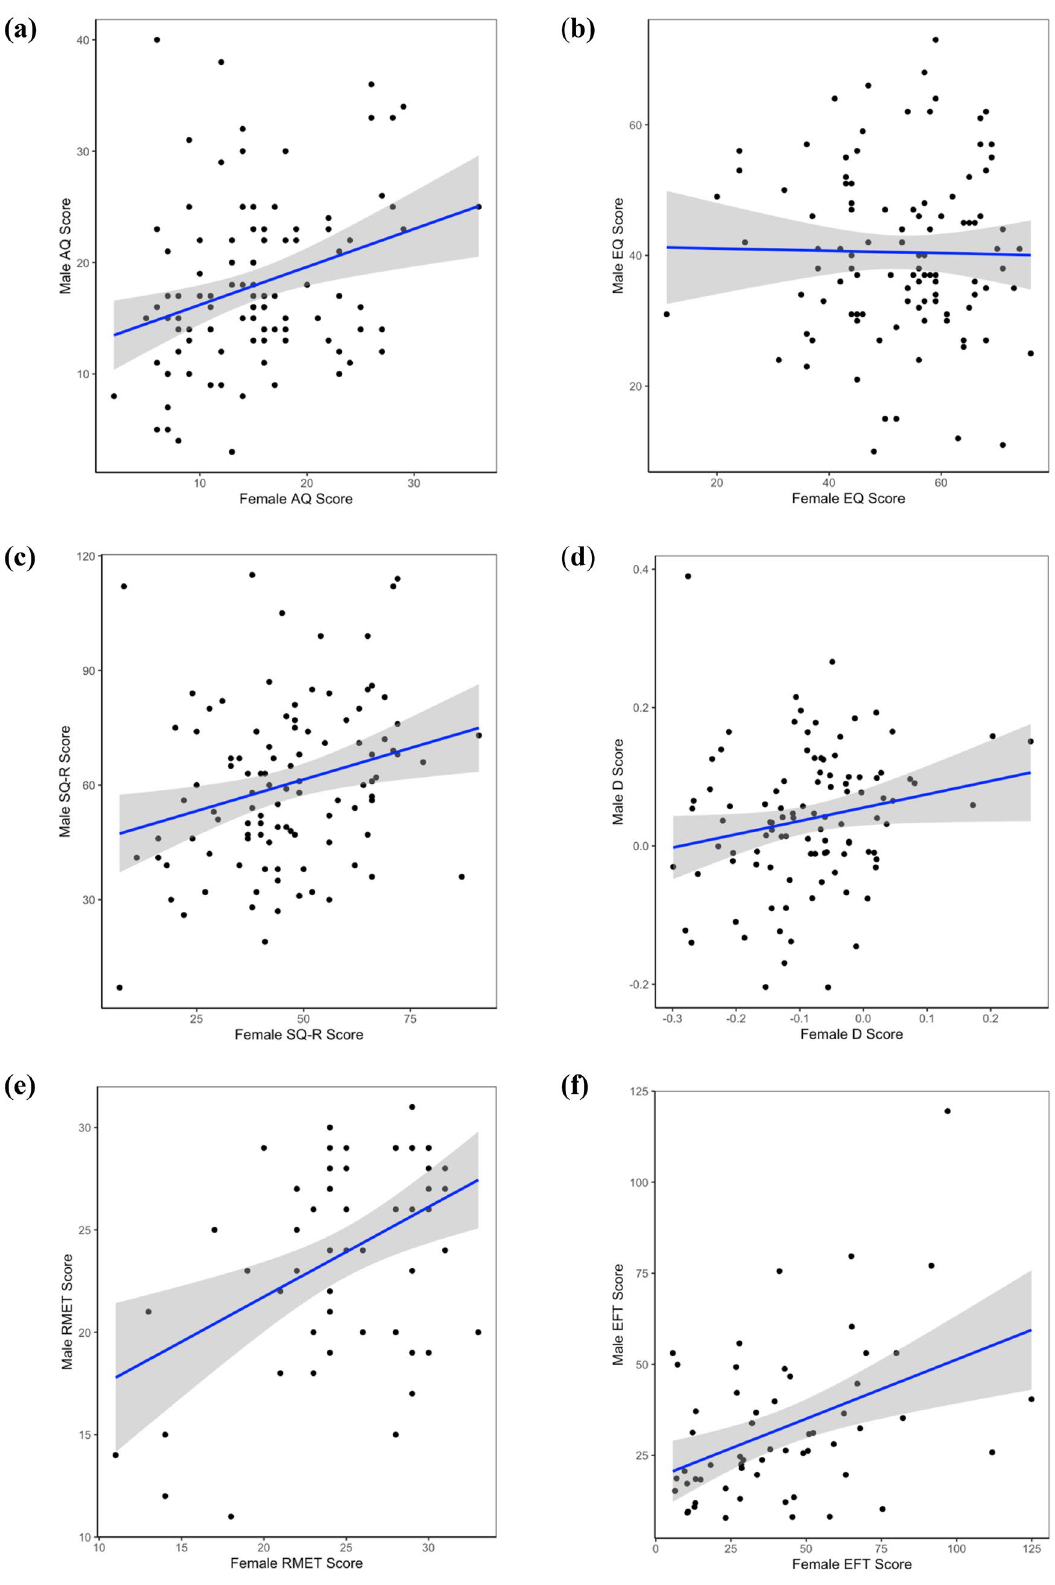
Figure 2. Scatterplots with regression lines and 95% confidence intervals demonstrating within-couple correlations observed for AQ ( a ), EQ ( b ), SQ-R ( c ), D score ( d ), RMET ( e ), and EFT ( f